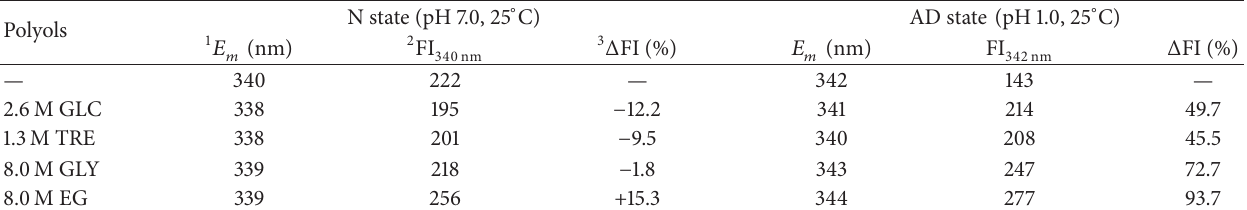
FI: Fluorescence intensity at 340/342nm. 3 Δ FI: Percentage change in the fluorescence intensity in the presence of